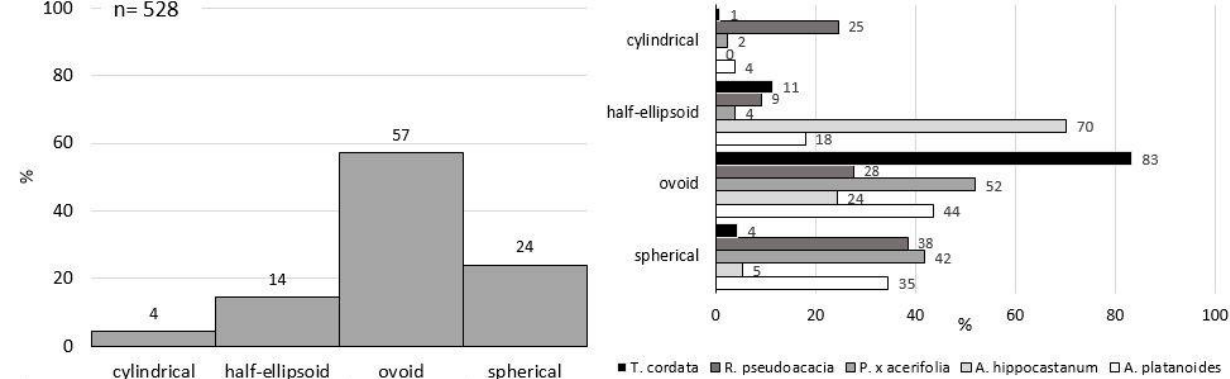
Figure 5. Percentage distribution of crown shapes of all trees measured ( left ) and according to tree species ( right ).